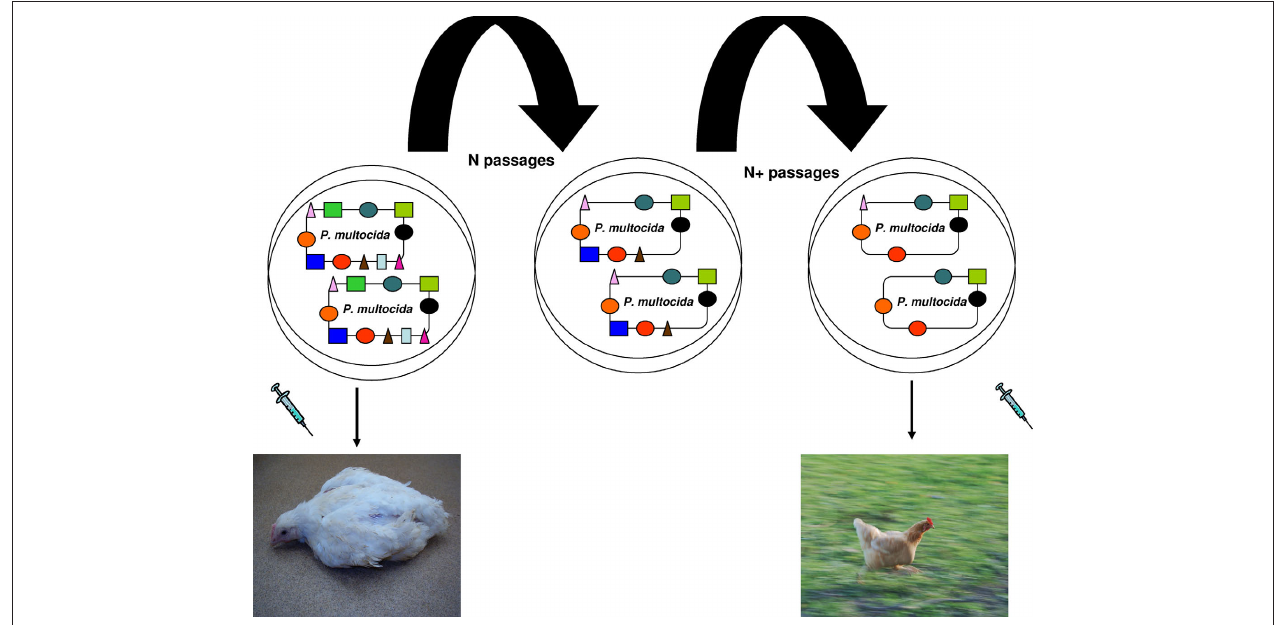
Figure 4 | Vaccine principle established by Pasteur. P. multocida virulence is attenuated by multiple culture passages under the same laboratory conditions. The attenuation coincides with genomic loss. Injection of the attenuated strain protected chickens from future P. multocida